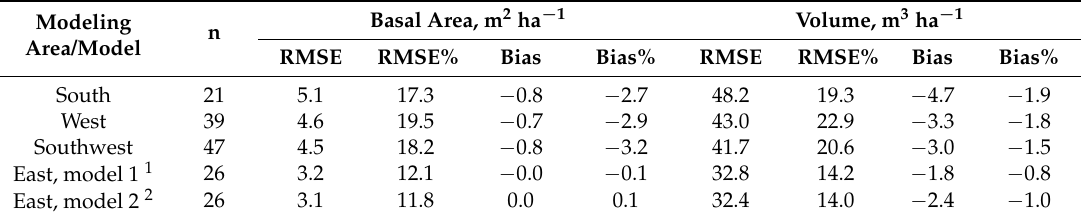
Table 4. Summary of plot-level validation results in the coniferous forest class. RMSE = root